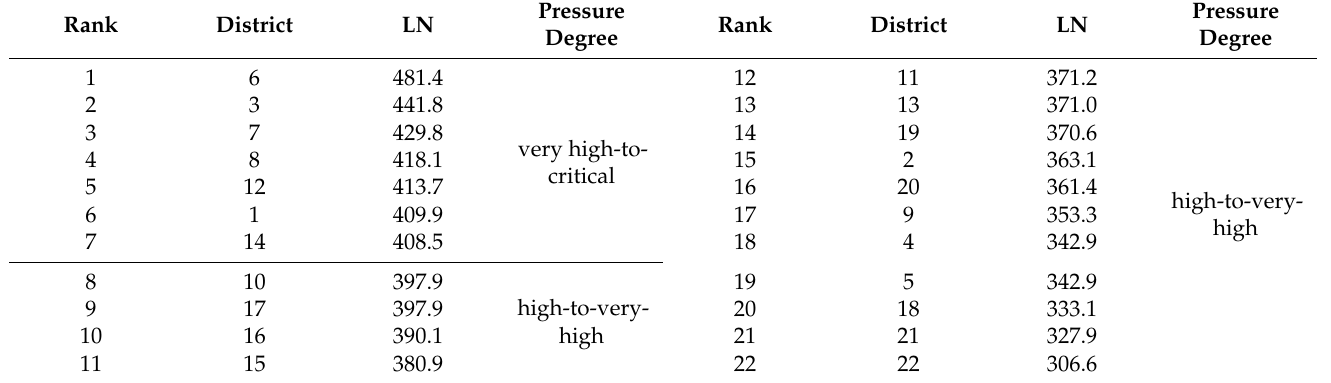
Table 4. Ranking of the LN of the human impacts on the ecosystem of each district of